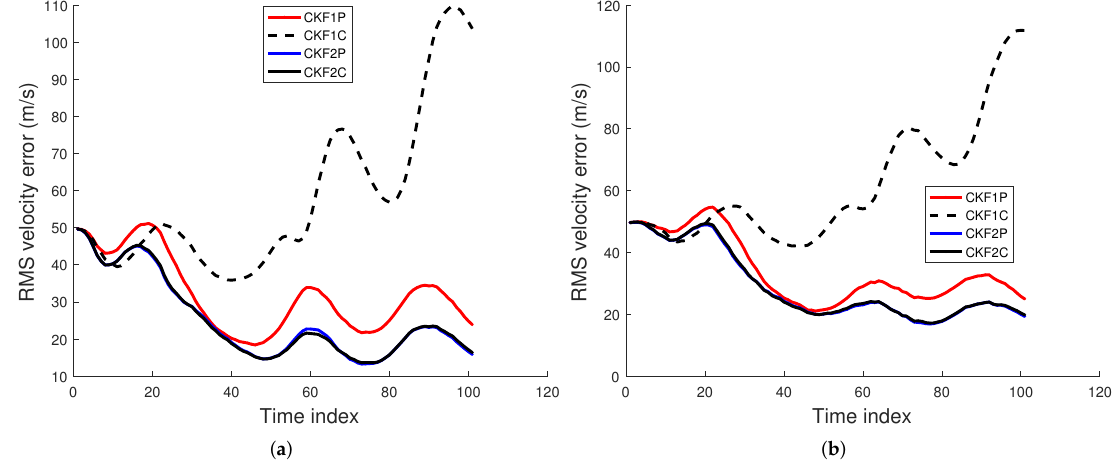
Figure 6. RMS velocity error using the prior variance P 0,p,1 from 500 Monte Carlo runs. ( a ) Angle SD of 1 mrad, ( b ) Angle SD of 2 mrad.